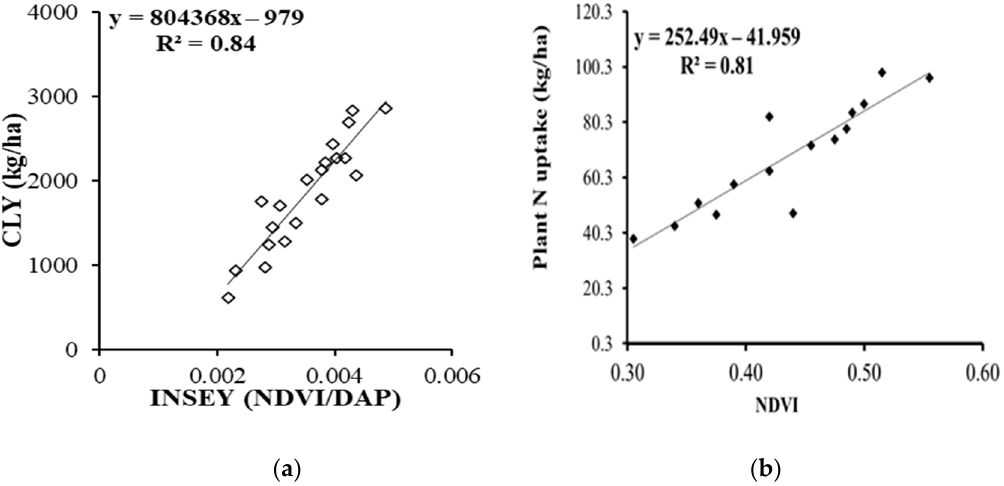
Figure 2. ( a ) Relationship of cotton lint yield (CLY) with INSEY (NDVI/DAP) data collected at dif- ferent time intervals ( b ) plant N uptake and NDVI . different time intervals ( b ) plant N uptake and